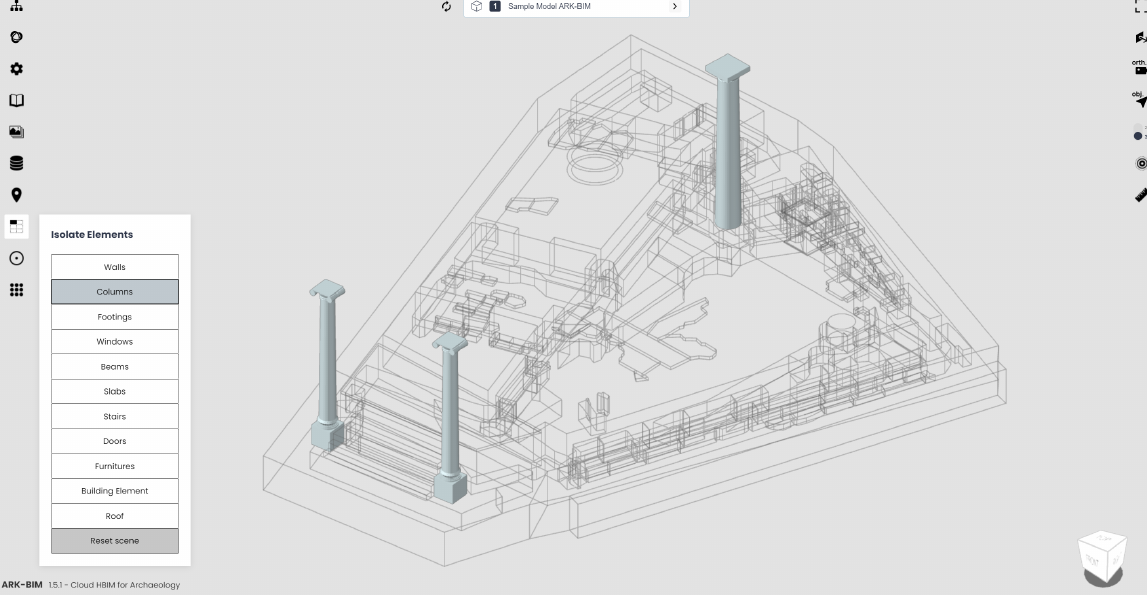
Figure 11. ARK-BIM (version 1.5.1): Isolate Elements plugin. Sample archaeological model with isolated columns and other elements in X-ray mode.